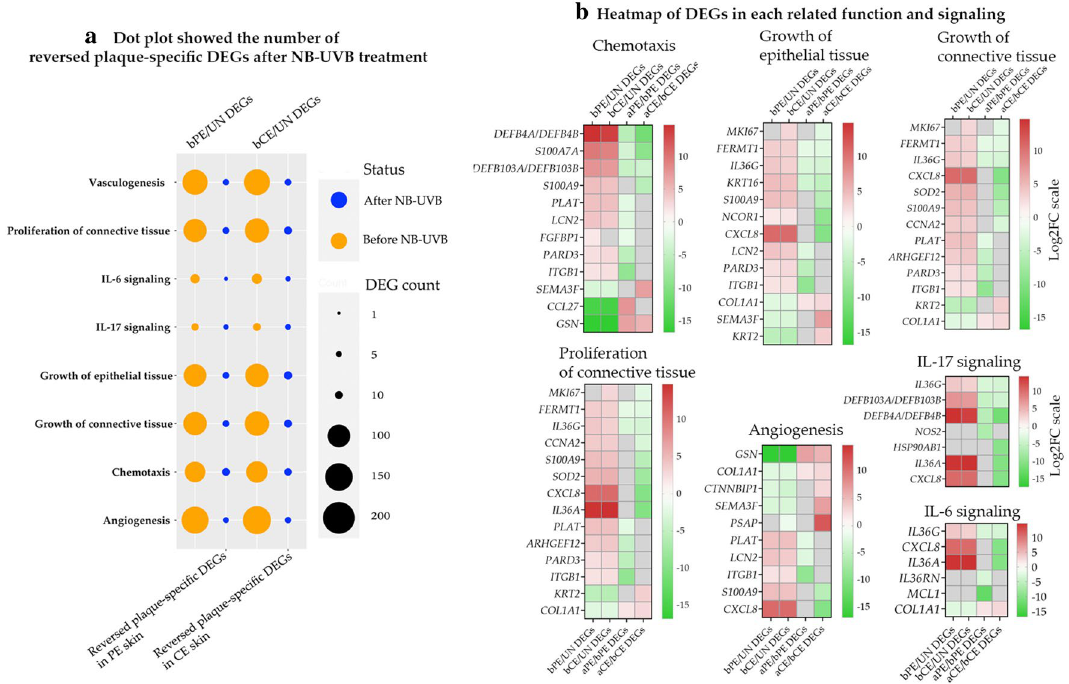
Figure 3. Reversed plaque-specific DEGs after NB-UVB treatment. ( a ) Dot Plot showing the number of reversed plaque-specific DEGs after NB-UVB treatment. ( b ) Heatmap of Log 2 FC showing examples of genes in each related function and signaling. Red color represents upregulated DEGs and green represents downregulated DEGs. aCE skin After-treatment CE skin, aPE skin After-treatment PE skin, bCE skin Before- treatment CE skin, bPE skin Before-treatment PE skin, DEGs Differentially expressed genes, FC Fold change, NB‑UVB Narrow band ultra violet B, UN skin Uninvolved